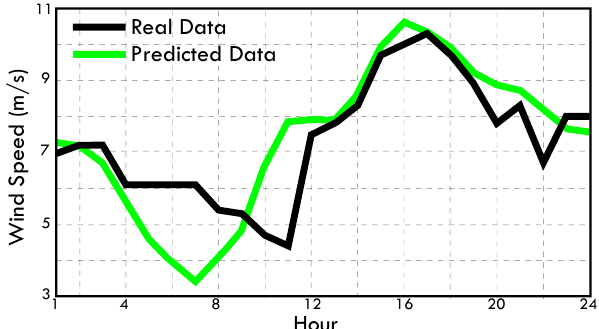
Figure 9. Day-ahead prediction using least-squares support vector machine (LSSVM) for a typical